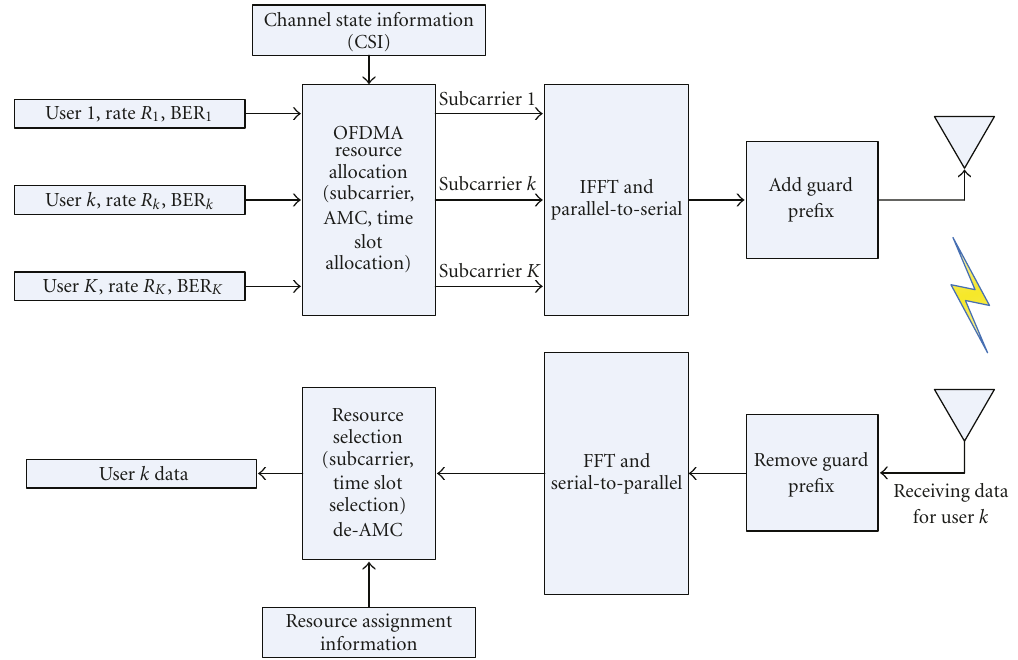
Figure 1: Diagram of orthogonal frequency division multiple access (OFDMA)